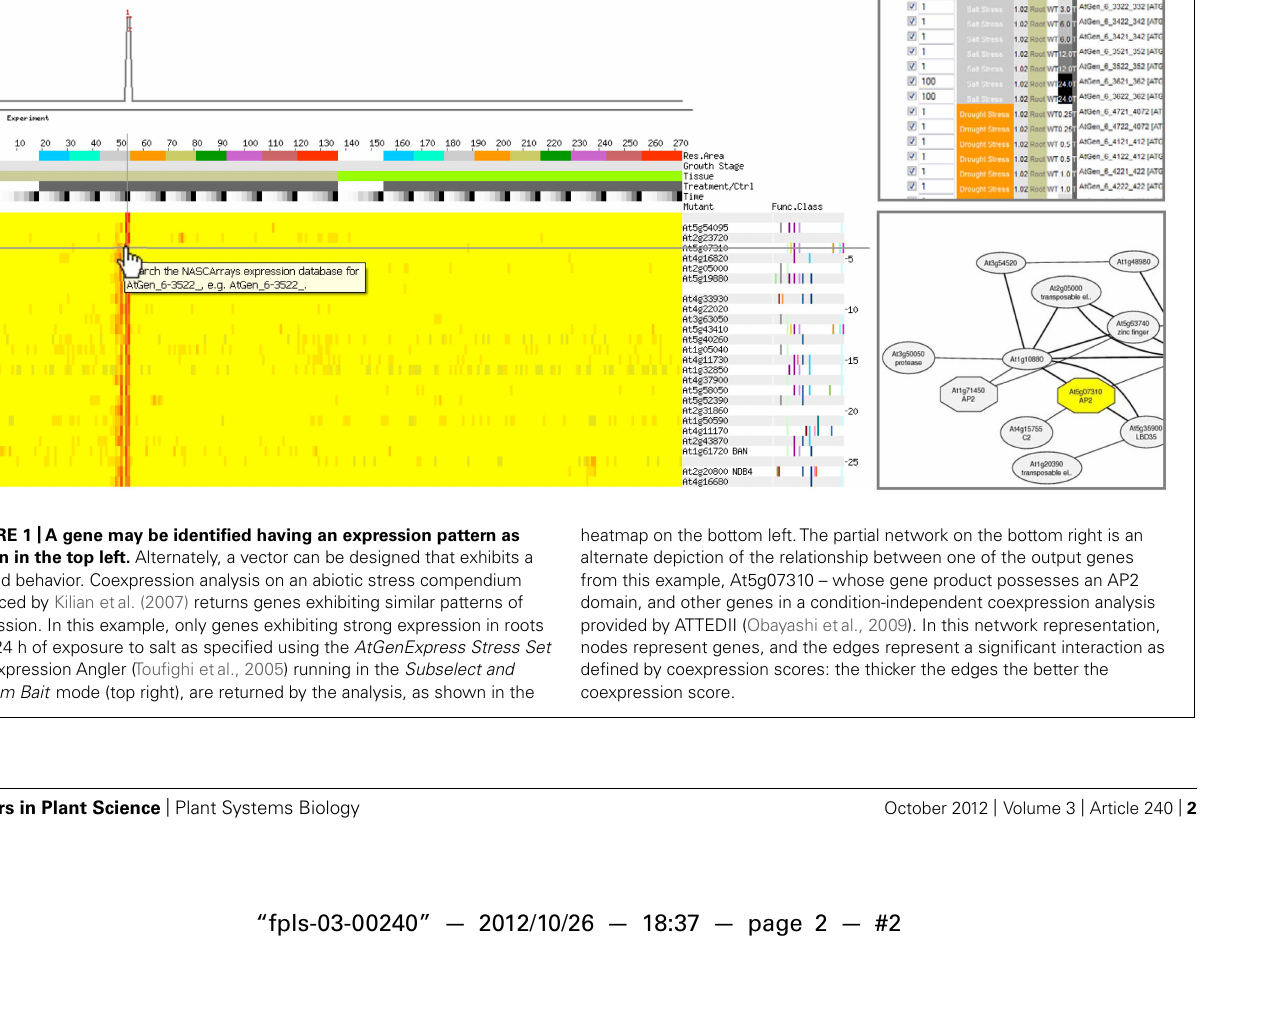
heatmap on the bottom left.The partial network on the bottom right is an alternate depiction of the relationship between one of the output genes from this example, At5g07310 – whose gene product possesses an AP2 domain, and other genes in a condition-independent coexpression analysis provided by ATTEDII (Obayashi etal., 2009). In this network representation, nodes represent genes, and the edges represent a significant interaction as defined by coexpression scores: the thicker the edges the better the coexpression